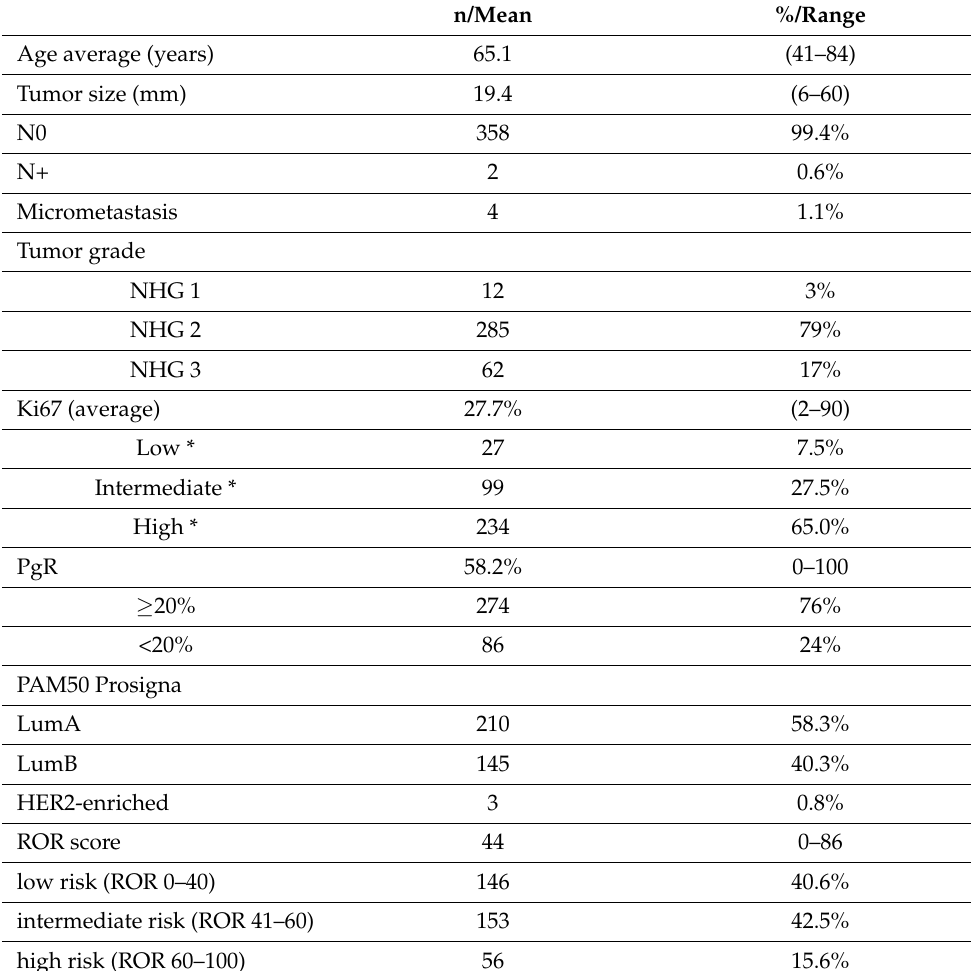
Table 3. Tumor and patient characteristics. N; lymph node status, NHG; Nottingham Histologic Grade, PR; progesterone receptor, ROR; risk of recurrence score. * Ki67 pathology lab specific limits are presented in Table